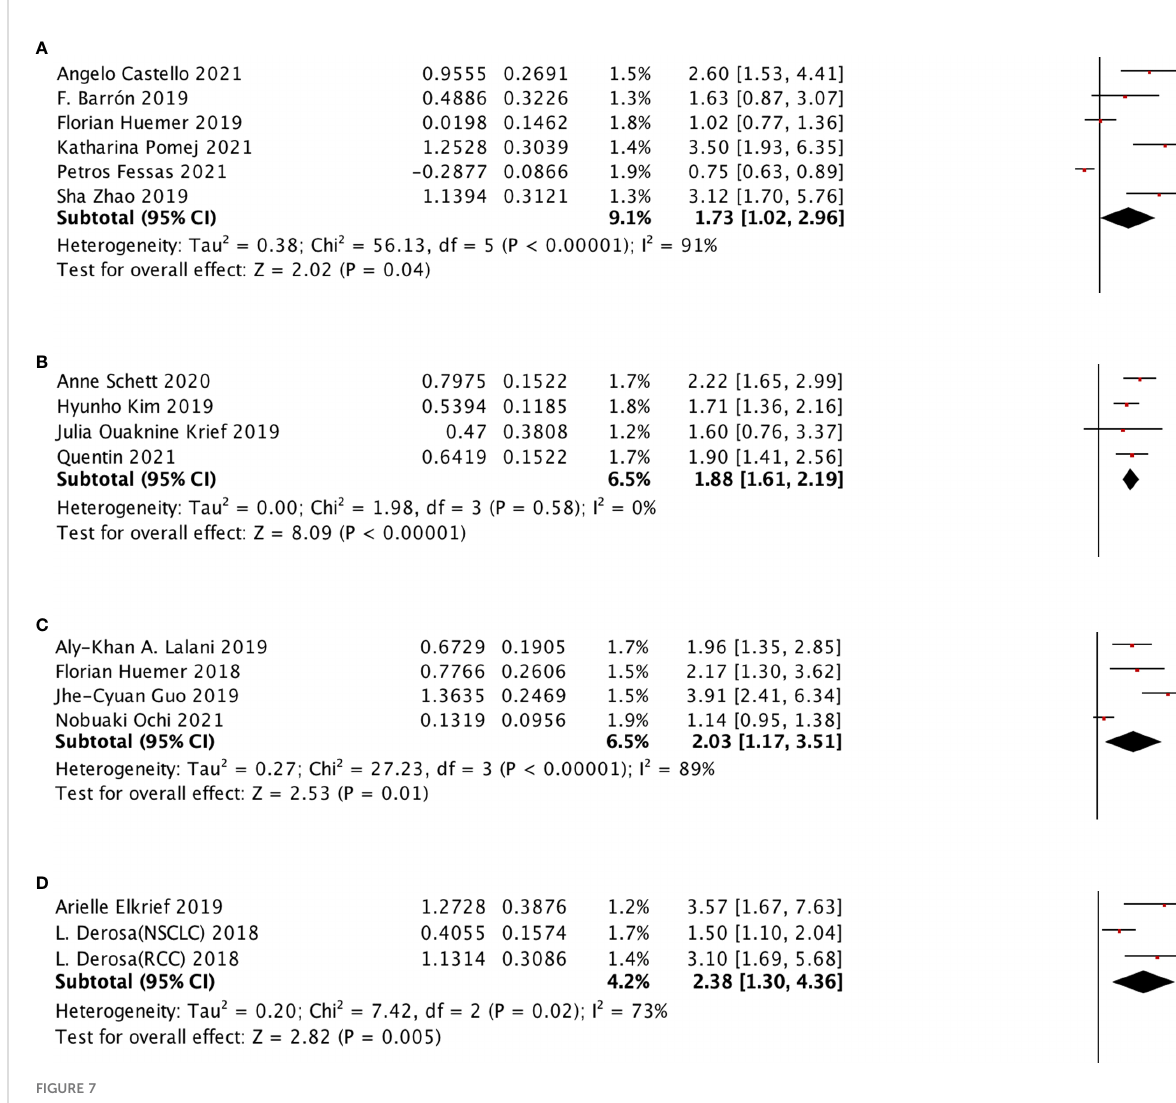
FIGURE 7 In different ATB window, the subgroup analysis between ATB use and PFS of cancer patients treated with ICIs. (A) ATB window (-30 days, 30 day); (B) ATB window (-60 days, 0 days); (C) ATB window (-60 days, 30 days); (D) ATB window (0 days, 30 days).